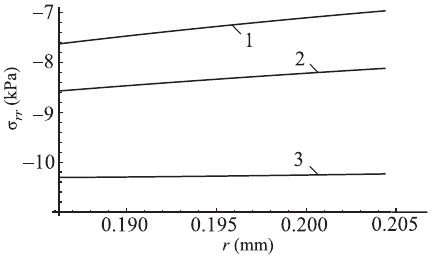
Figure 4. Stress σ rr vs radial coordinate (circular coordinate ϕ = 0): curves 1, 2, 3 correspond to values ν = 0 . 30;0 . 40;0 . 49, respectively.